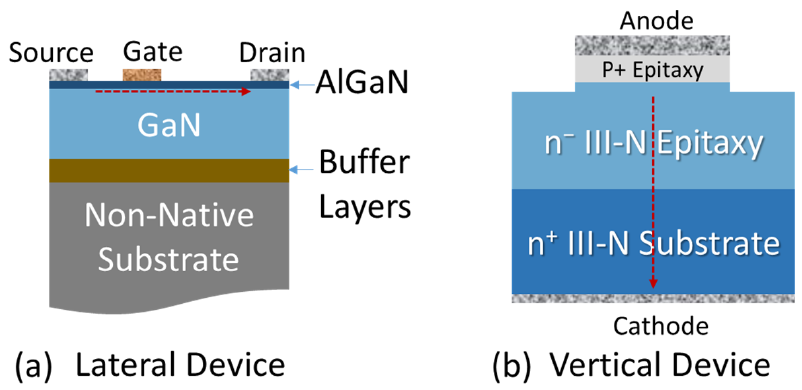
Figure 1. Illustration of the difference in geometry and current path (red dotted line) on ( a ) a standard lateral device, in this case and AlGaN/GaN HEMT grown heteroepitaxially on a non-native substrate and ( b ) a homoepitaxial vertical p-i-n diode. In the lateral HEMT, the current path is at the surface of the wafer, traveling between the source and the drain. In the vertical, the path is from top to bottom, through both the epitaxy and the substrate.